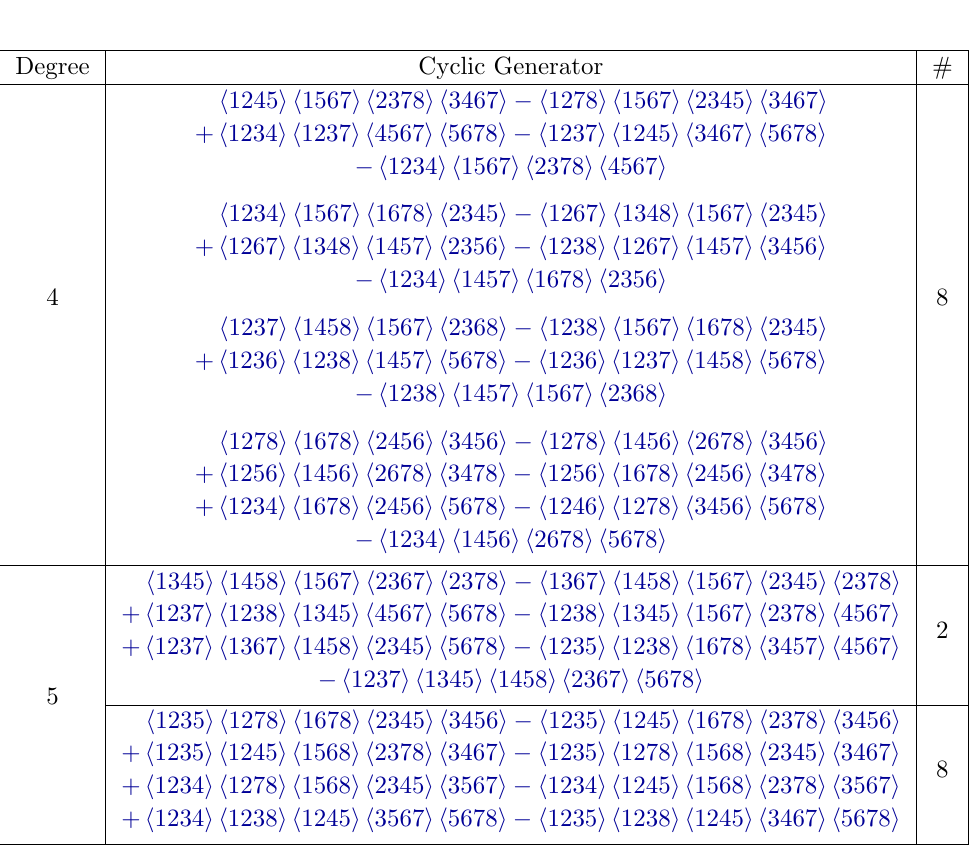
Table 6 . Cyclic generators of the eight-particle alphabet of degree 4 and 5. In the last column, the size of the cyclic orbit of each generator is given. The generators whose dihedral (cid:13)ip is not contained in the alphabet are highlighted in